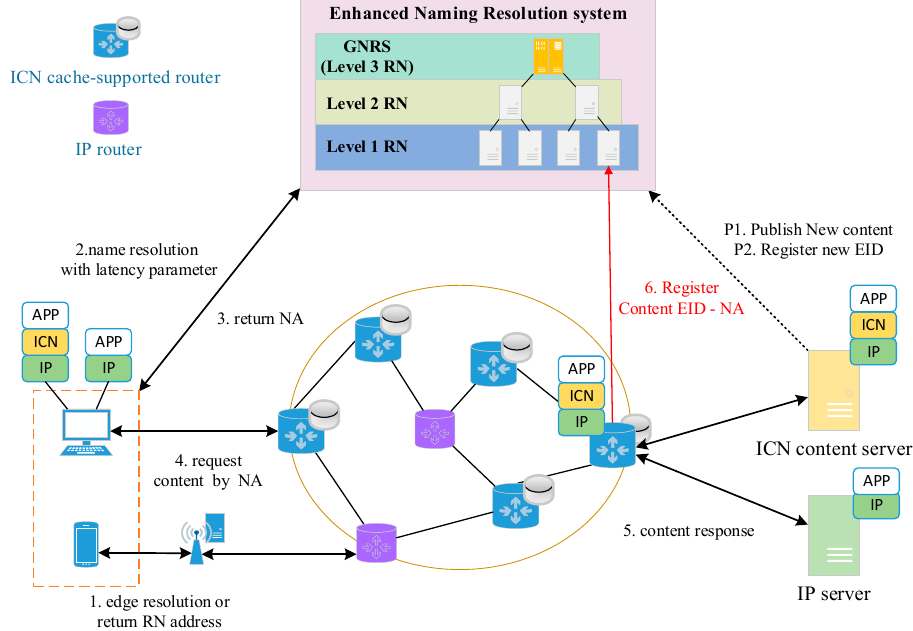
Figure 2. A specific caching mechanism based on an enhanced name resolution system (ENRS).